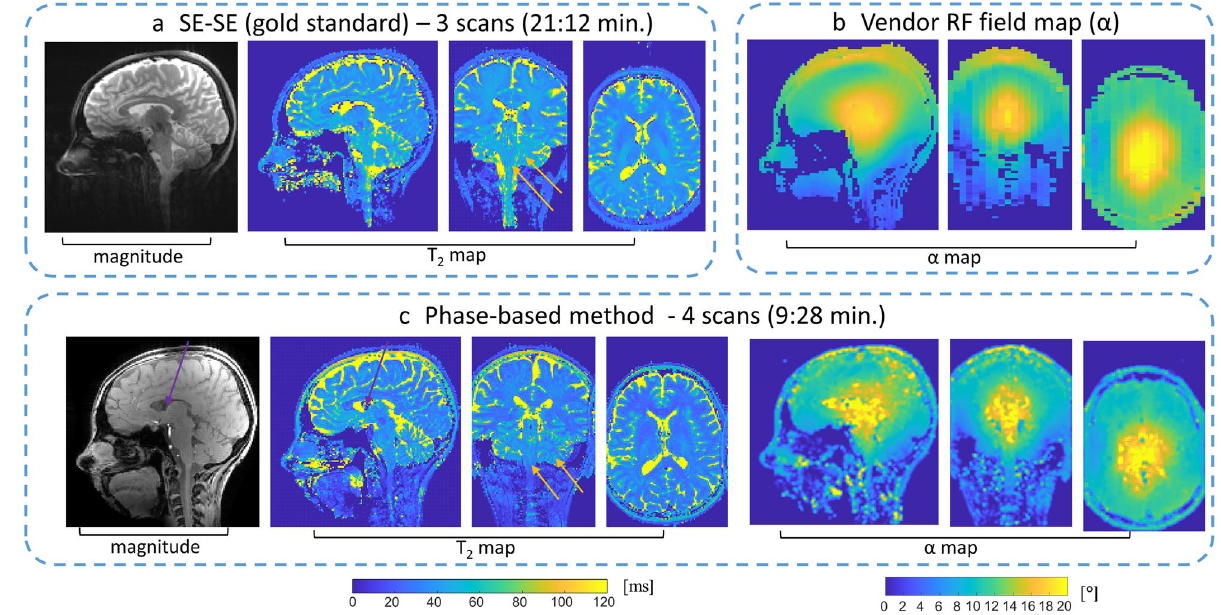
Figure 5. Human imaging—T 2 from the phase-based method or SE–SE, and α from the phase-based method or the vendor’s scan. ( a ) SE–SE Sagittal magnitude image at TE = 30 ms and the estimated T 2 maps in three main cross-sections. ( b ) An α map using the vendor’s pulse sequence. ( c ) Sagittal magnitude image with φ inc = 3 and α = 15°, as well as the estimated T 2 and α maps in three main cross-sections. α map shown here was smoothed by a 3 × 3 filter to reduce the effect of local CSF signal. Orange arrows point to the cerebellum and brainstem regions suffering from low flip angles due to B 1 inhomogeneity; their inner structure is much more pronounced—and clearly visible—in the phase-based T 2 images. Purple arrows point to a region in the CSF that resulted in a low magnitude signal.